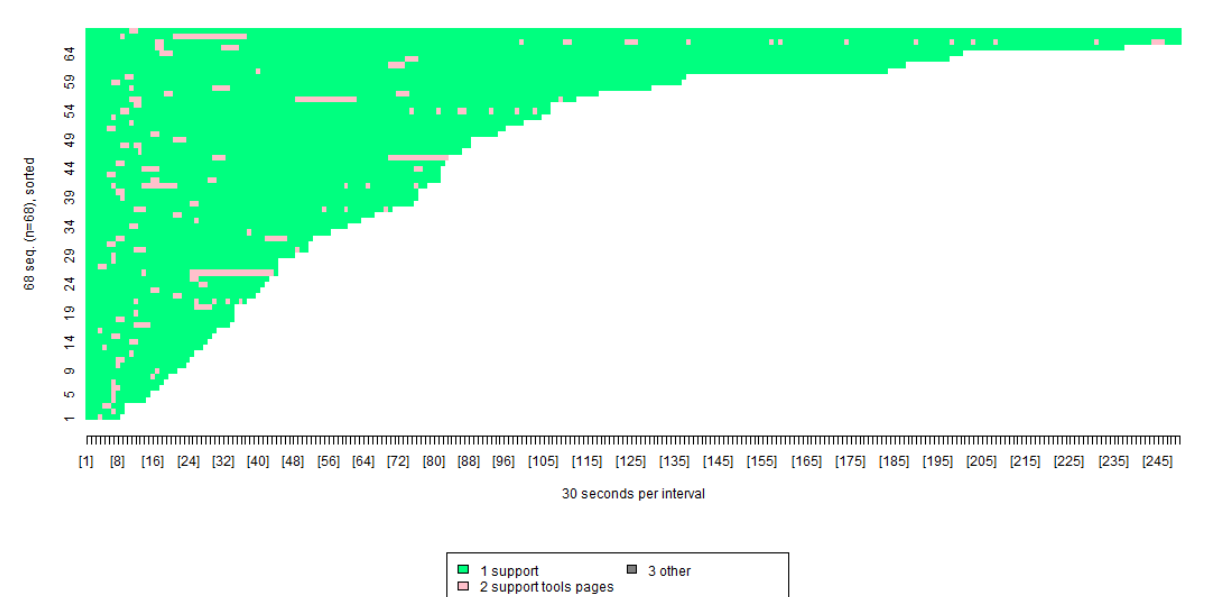
Figure 6. Visualization of reuse of the support tools in relation to the session on getting